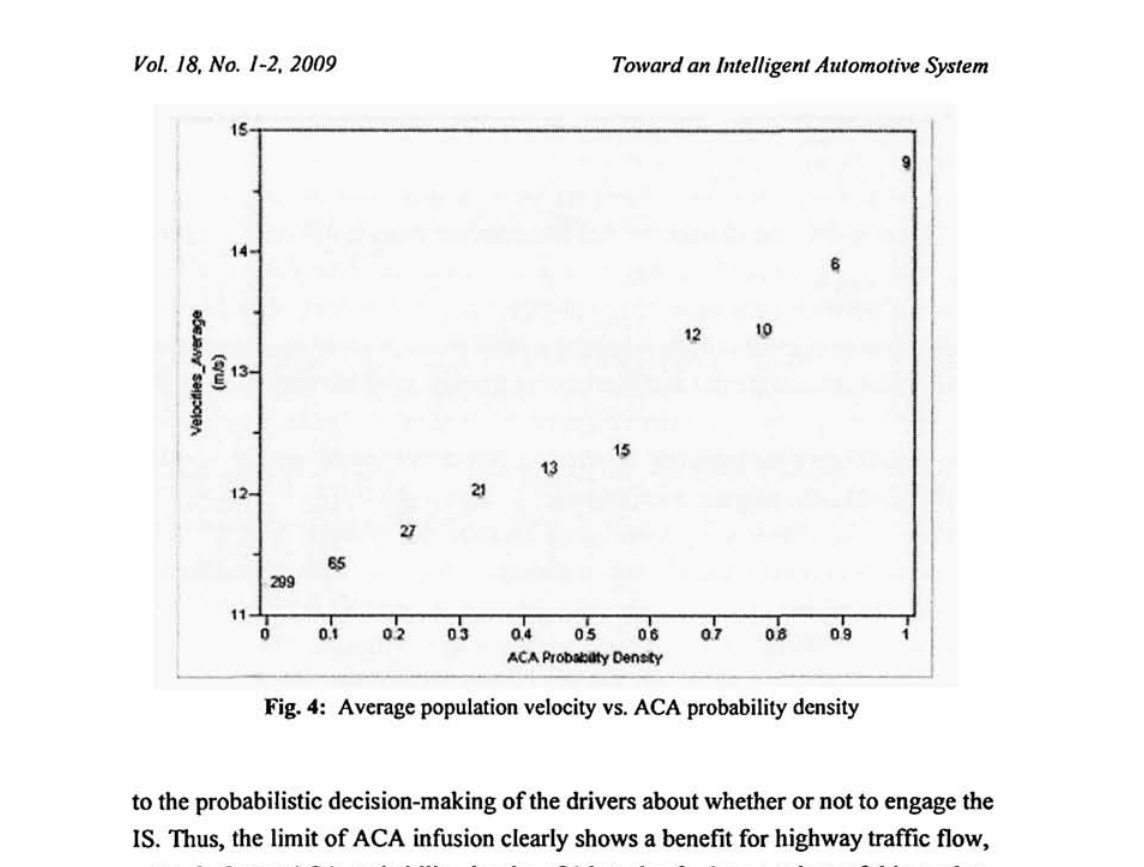
Fig. 4: Average population velocity vs. ACA probability